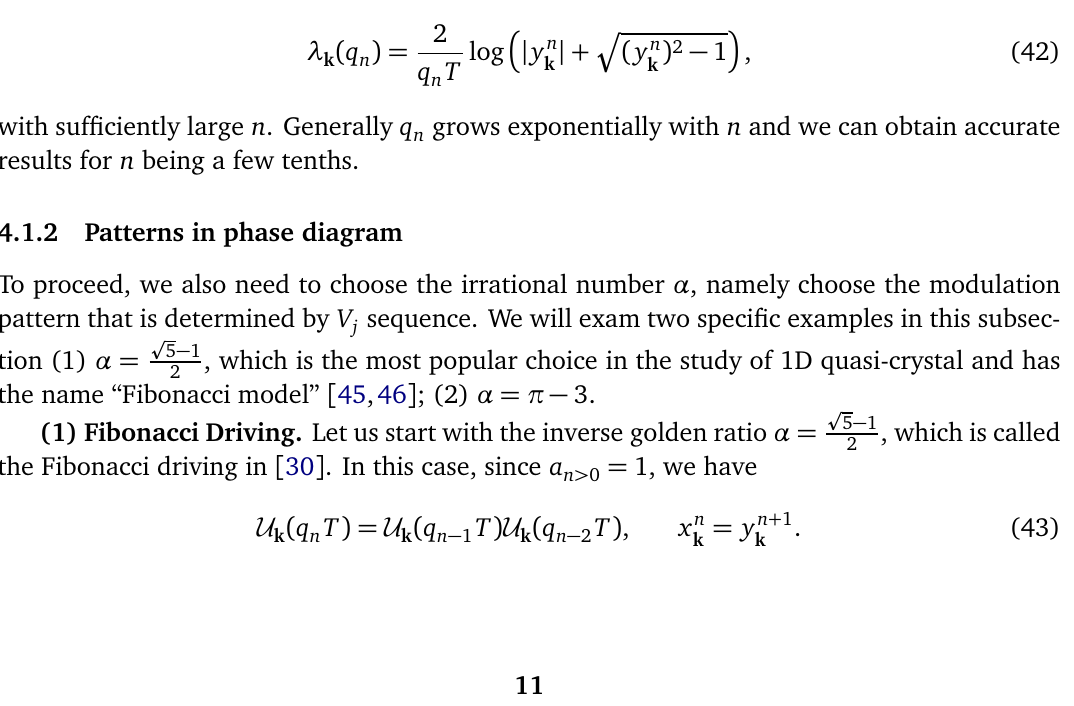
Figure 3: (a). The Fibonacci modulation of the scattering length. (b). A density plot T ) determined by taking a period of q of log ( λ k in the heating phase almost everywhere. (c-d). The the heating rate λ g n T = 2 determined by taking a period of q 0 0 self-similar structures as in [ 30 ]